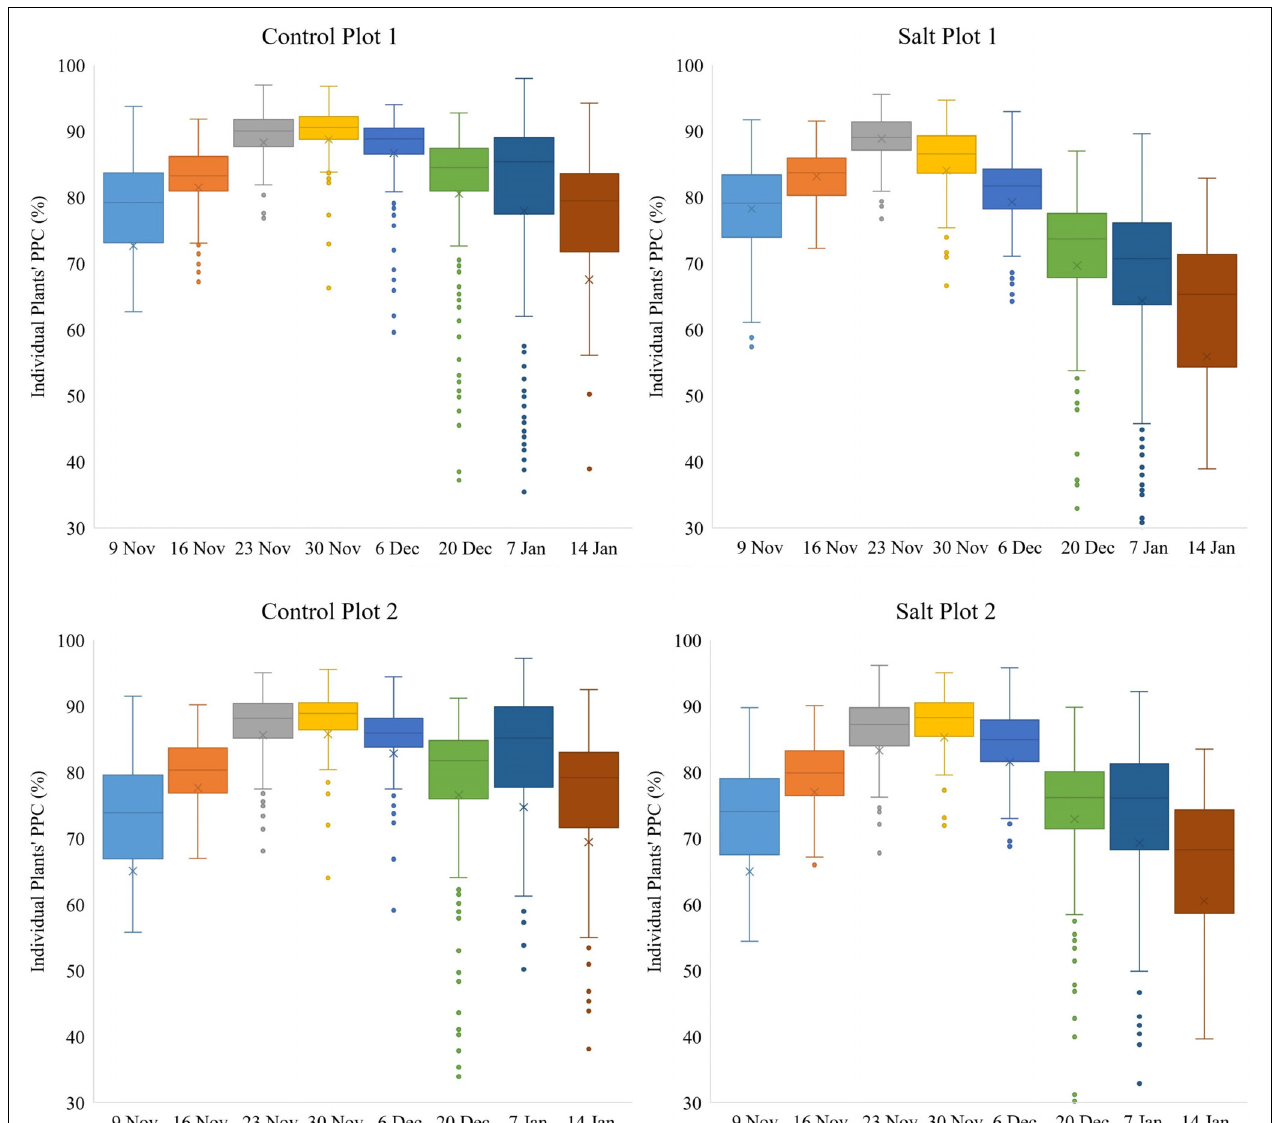
FIGURE 9 | Box-and-whisker plots, showing the variation throughout the growing season in PPC of individual plants, occurring within each of the four plots. The boxes cover the data from Q1 to Q3 with the line through each box and the X, displaying the median and mean values, respectively. The whiskers show the limits of Q1–1.5(IQR) and Q3+1.5(IQR) and dots indicate outliers from the population of